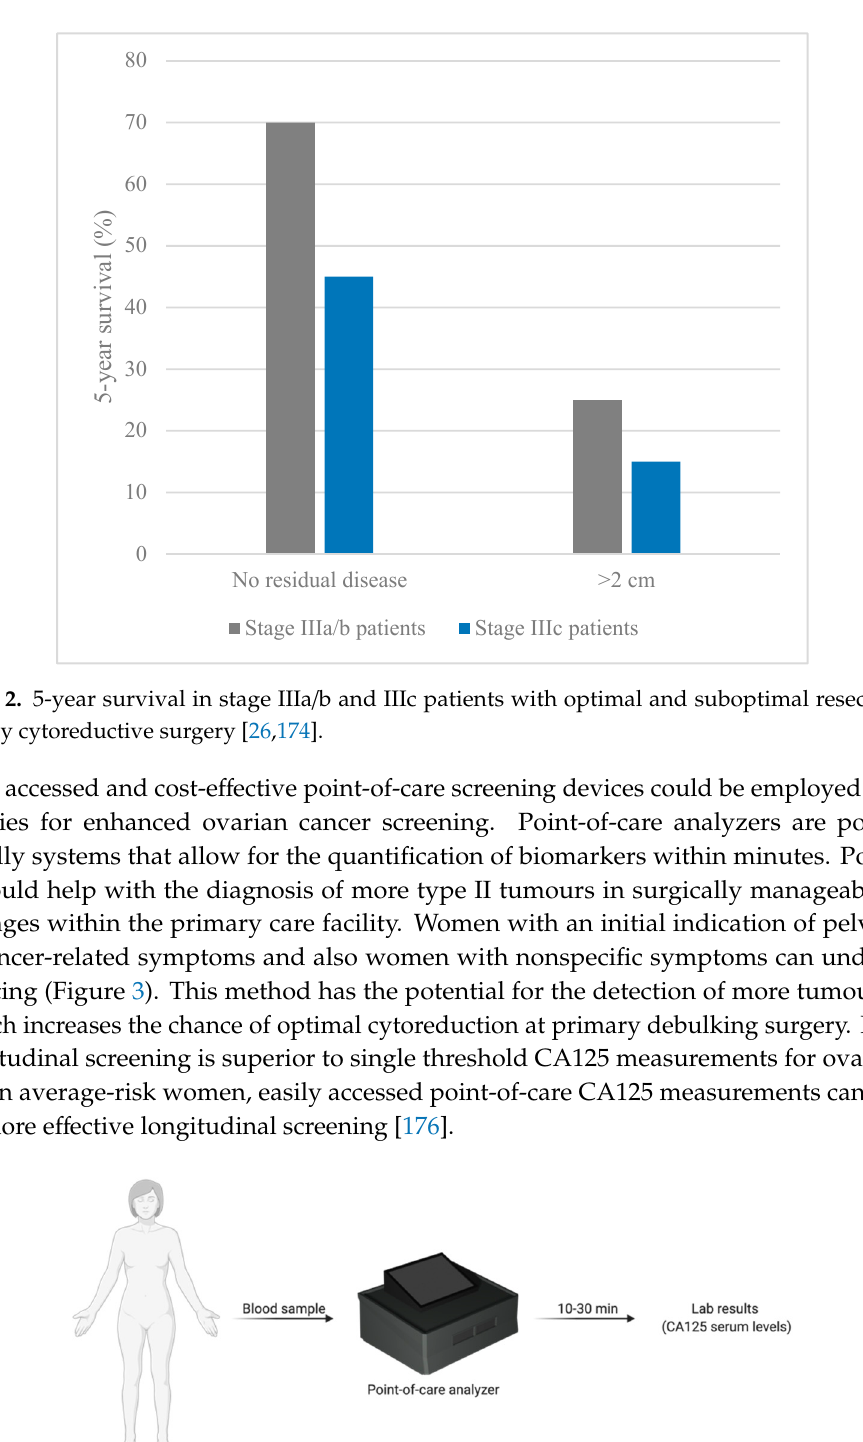
Figure 3. Point-of-care biomarker analyzer for primary care facilities.